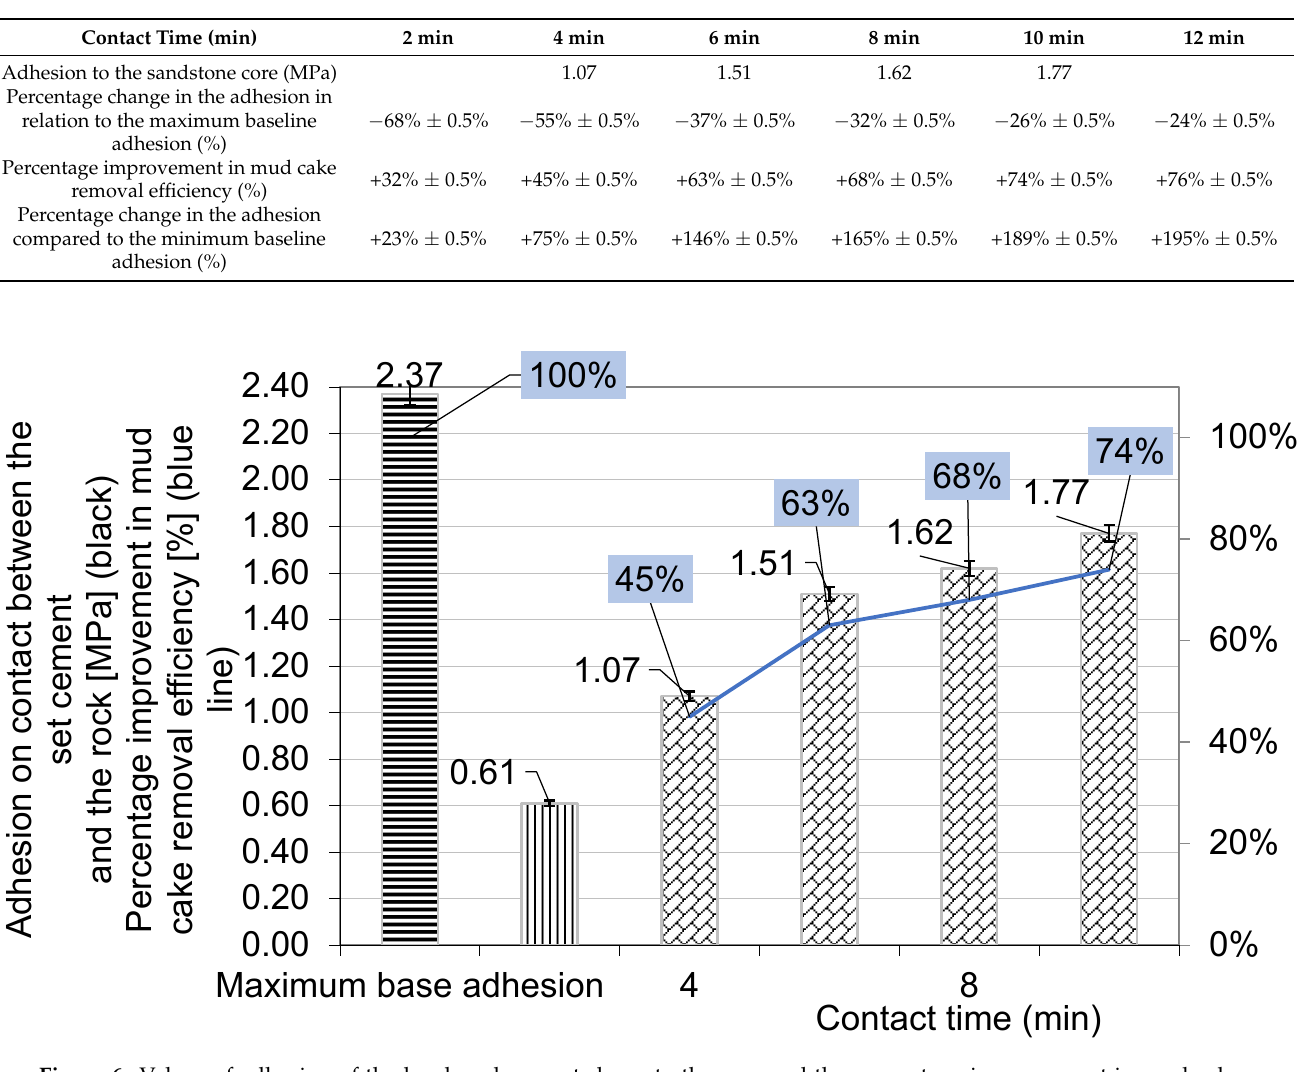
Figure 6. Values of adhesion of the hardened cement slurry to the core and the percentage improvement in mud cake removal (adhesion 2.37 = 100% mud cake removal). Results after different washing times.